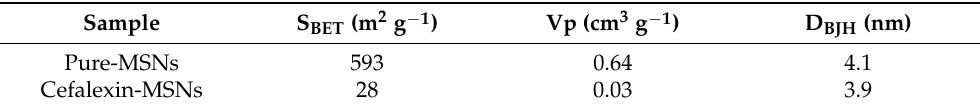
Figure 3. Nitrogen adsorption–desorption isotherms ( a ) and Barrett–Joyner–Halenda pore distribu- tions ( b ) of MSNs and Cefalexin@MSNs. Table 2. S BET , V p , and D BJH of MSNs and Cefalexin@MSNs.